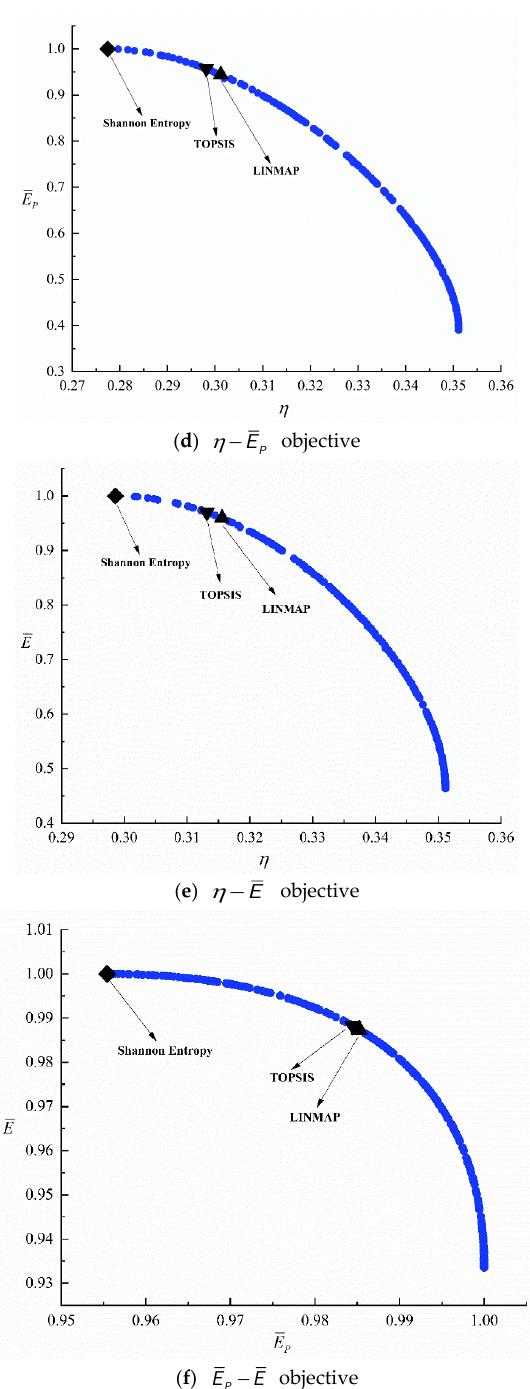
Figure 5. Pareto frontier for six bi-objective optimizations.